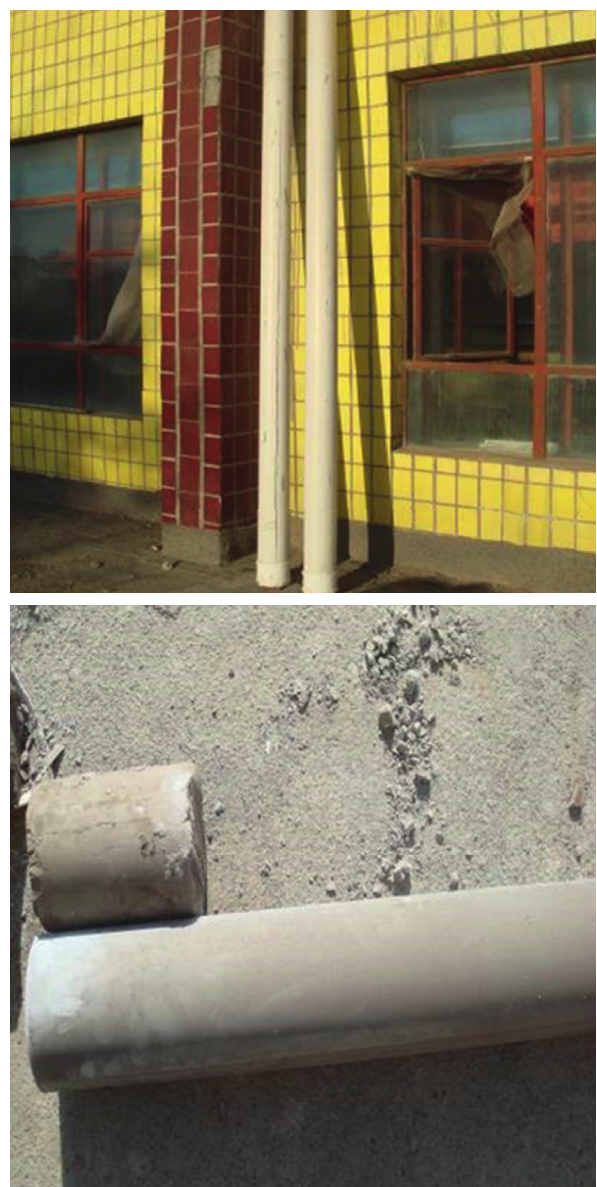
Figure 12: Consolidating objects of slurry.